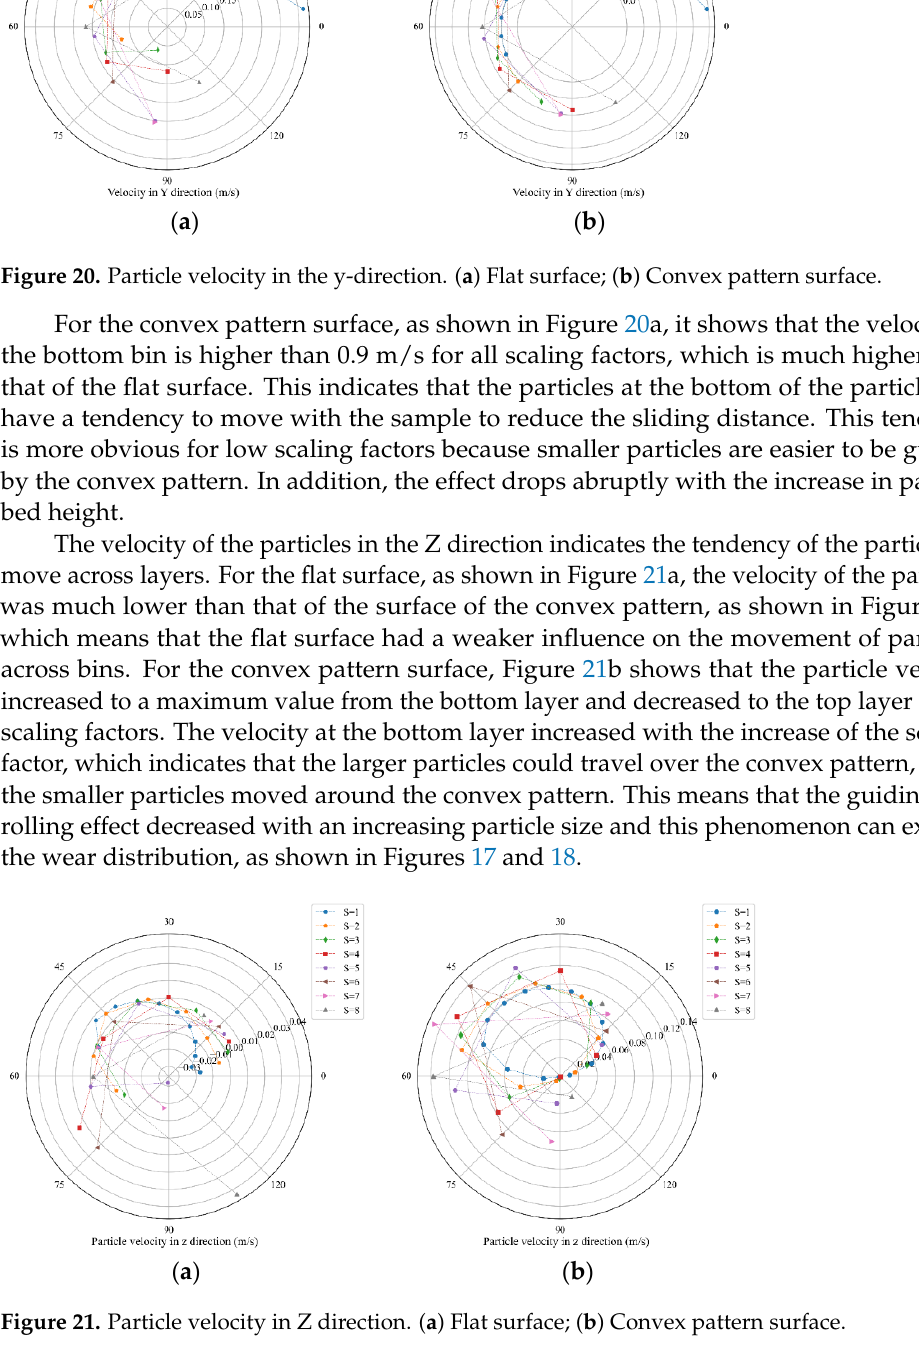
( b ) Figure 22. Particle velocity in the X direction. ( a ) Flat surface; ( b ) Convex pattern surface. 5.3.2. Angular Velocity Behavior The angular velocity was analyzed with a different bin group, as shown in Figure 23. The angular velocity focuses on the bottom layer of particles, as the bottom layer reflects the rolling and guiding effect of the convex pattern. The depth and width of each bin are related to the scaling factor and equal to the depth of the bin, as shown in Figure 10.